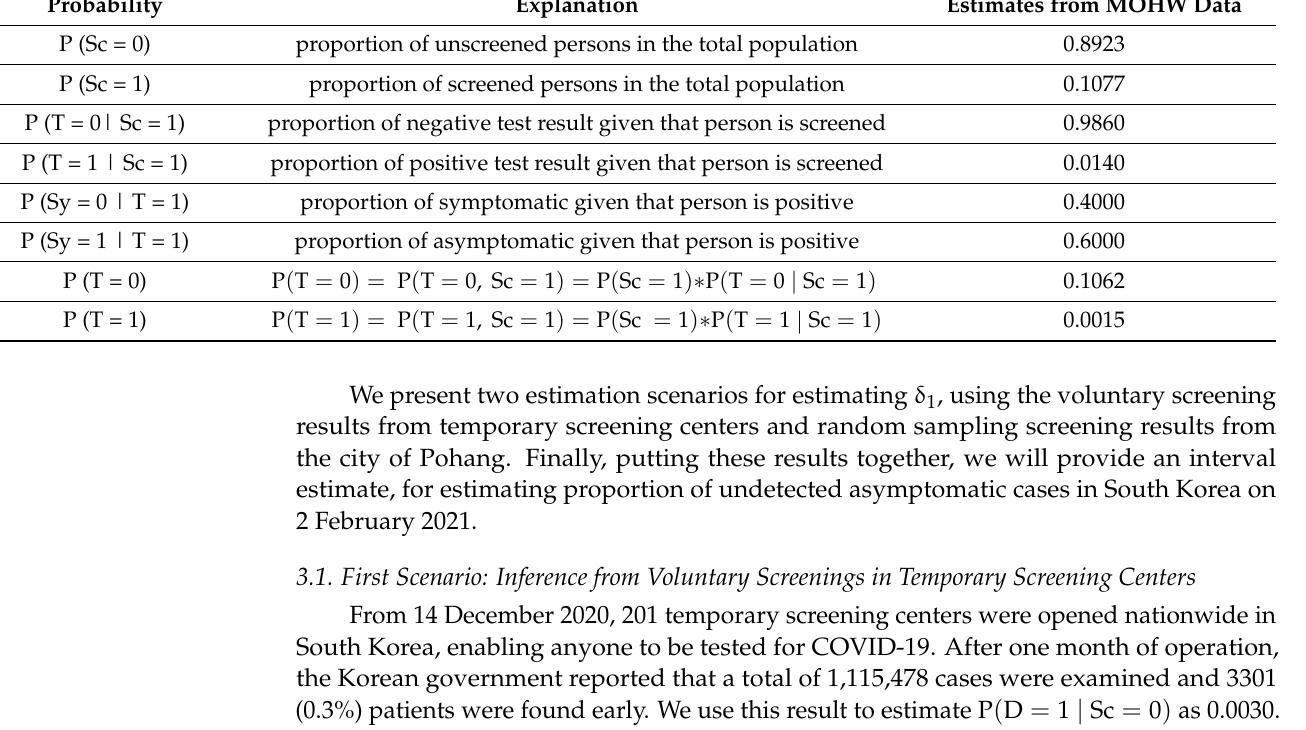
Table 2. Estimates of probabilities using data from Ministry of Health and Welfare of South Korea (MOHW) until 2 Febru- ary 2021.